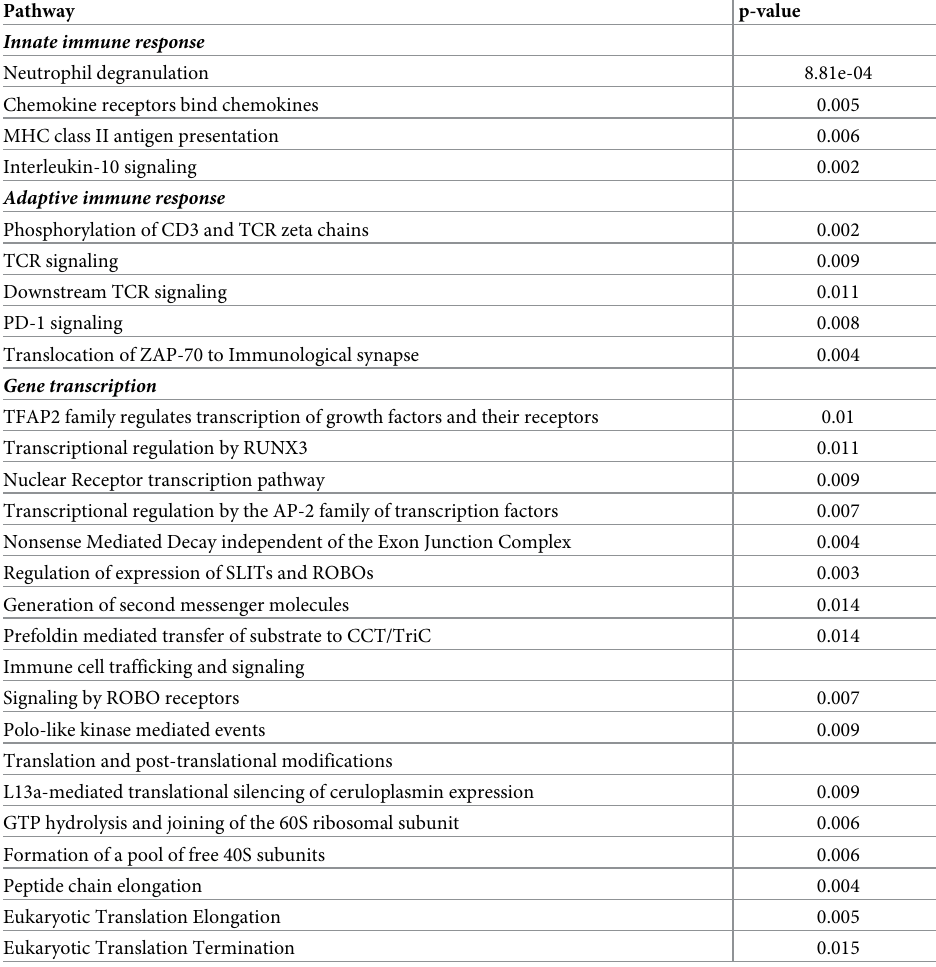
Table 3. The 25 most involved pathways in rabbit DED.